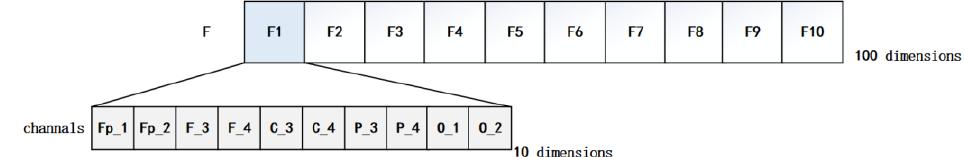
Figure 7. Illustration of feature vector F.